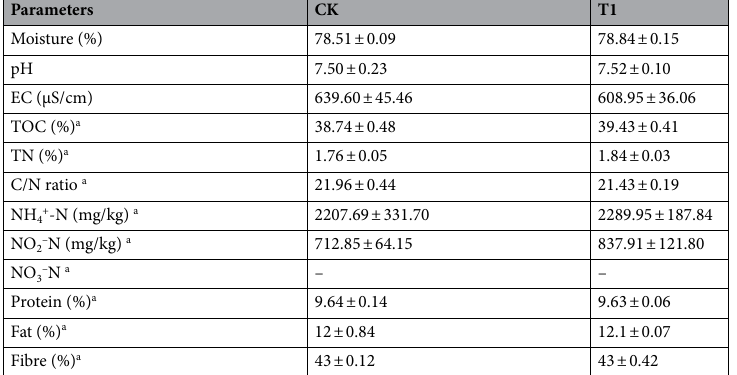
Table 1. Physicochemical properties of the raw materials used in this study. CK (bean dregs), T1 (bean dregs + 10% Geobacillus toebii ), EC (electrical conductivity), TOC (total organic carbon), TN (total nitrogen),